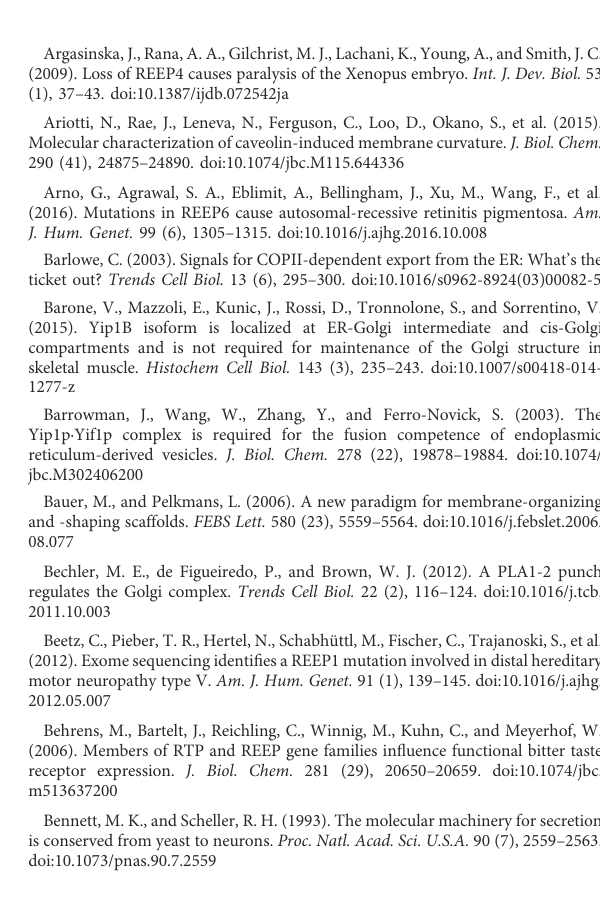
Multiple Sequence Alignment and Jalview (Waterhouse et al., 2009; Madeira et al., 2022). SUPPLEMENTARY FIGURE S5 YifFamilyMultipleSequenceAlignment.AminoacidalignmentofYif1A/B. GenBank and HGNC names and total amino acid number are listed on the left. Amino acid types are color coded by type of amino acid: Hydrophilic Basic — Red, Hydrophilic Acidic — Purple, Hydrophilic Uncharged Polar — Green, Hydrophobic Aromatic/Aliphatic — Blue. Conservation and consensus sequences are shown. Alignments and fi nal outputs were created using EMBL-EBI Multiple Sequence Alignment and Jalview (Waterhouse et al., 2009; Madeira et al., 2022). SUPPLEMENTARY FIGURE S6 PRAF Multiple Sequence Alignment. Amino acid alignment of PRAF1-3. GenBank and HGNC names and total amino acid number are listed on the left. Amino acid types are color coded by type of amino acid: Hydrophilic Basic — Red, Hydrophilic Acidic — Purple, Hydrophilic Uncharged Polar — Green, Hydrophobic Aromatic/Aliphatic — Blue. Conservation and consensus sequences are shown. Alignments and fi nal outputs were created using EMBL-EBI Multiple Sequence Alignment and Jalview (Waterhouse et al., 2009; Madeira et al., 2022). SUPPLEMENTARY FIGURE S7 IntracellularLocalizationofYipSuperfamilyofMSAPs.Intracellularlocalization of various Yip superfamily members and known binding partners is shown within the ER, Golgi, and ERGIC compartments, including intracellular transportvesicles,COPIandCOPII.Modeledproteinsarenotshowntoscale relative to their amino acid sequence. ER = Endoplasmic Reticulum, ERES = ER Exit Site, ERGIC = ER/Golgi Intermediate